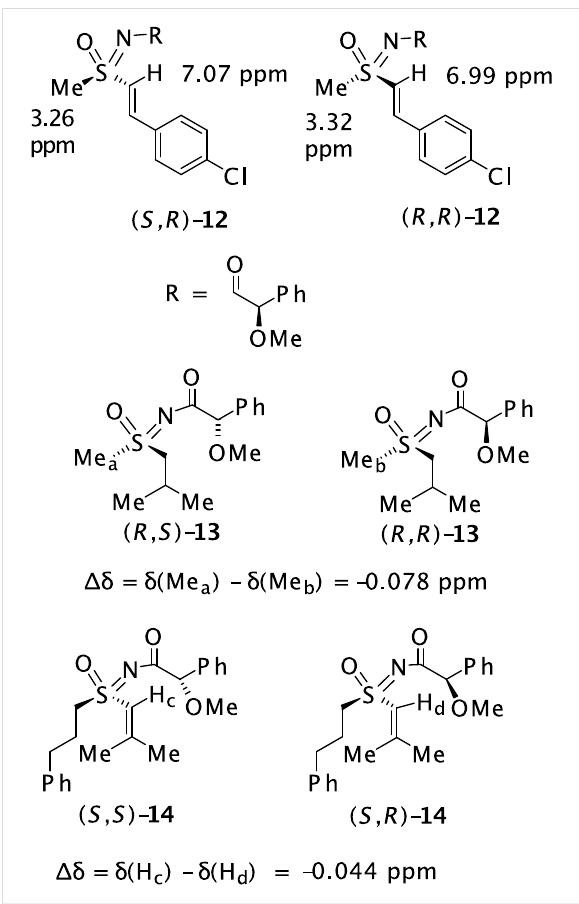
Figure 2: Selected NMR Characteristics of sulfoximine amides 12, 13 and 14